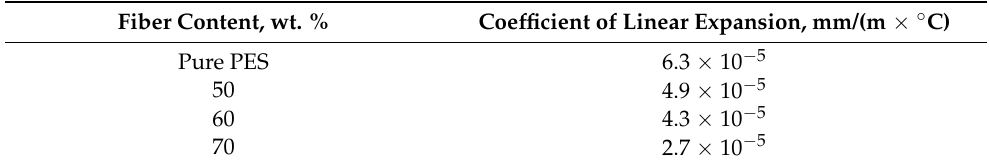
Table 5. Thermal expansion of composite materials reinforced with initial CF, measured perpendicular to the layers of carbon fibers.